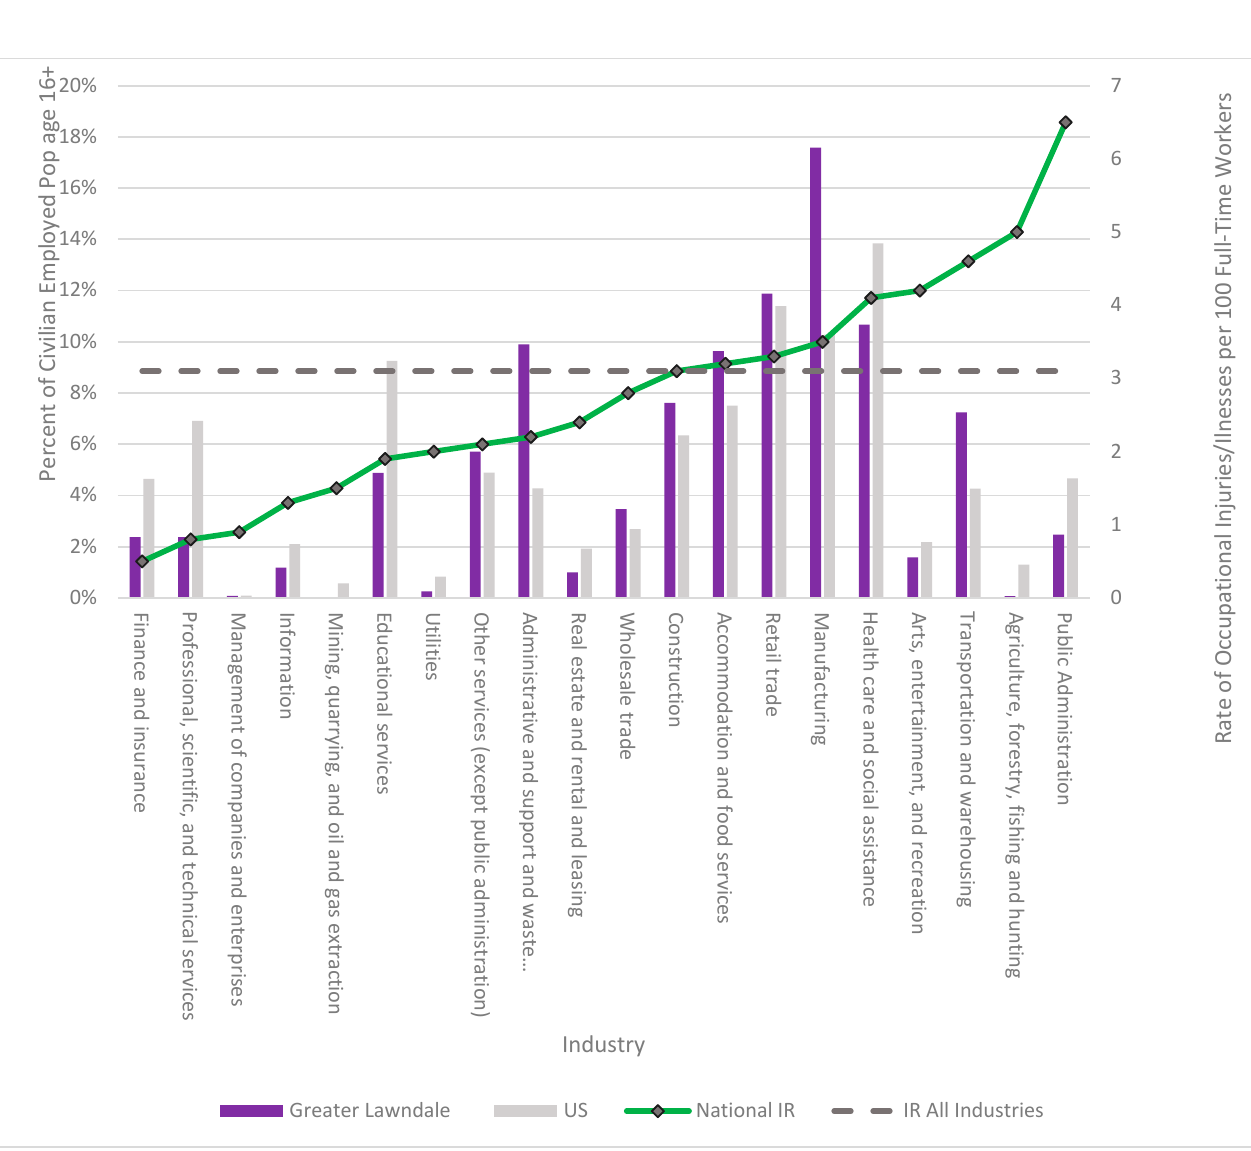
Figure 1. Industry Employment for Greater Lawndale and the United States compared to the Occupational Injury and Illness Rate for the United States.